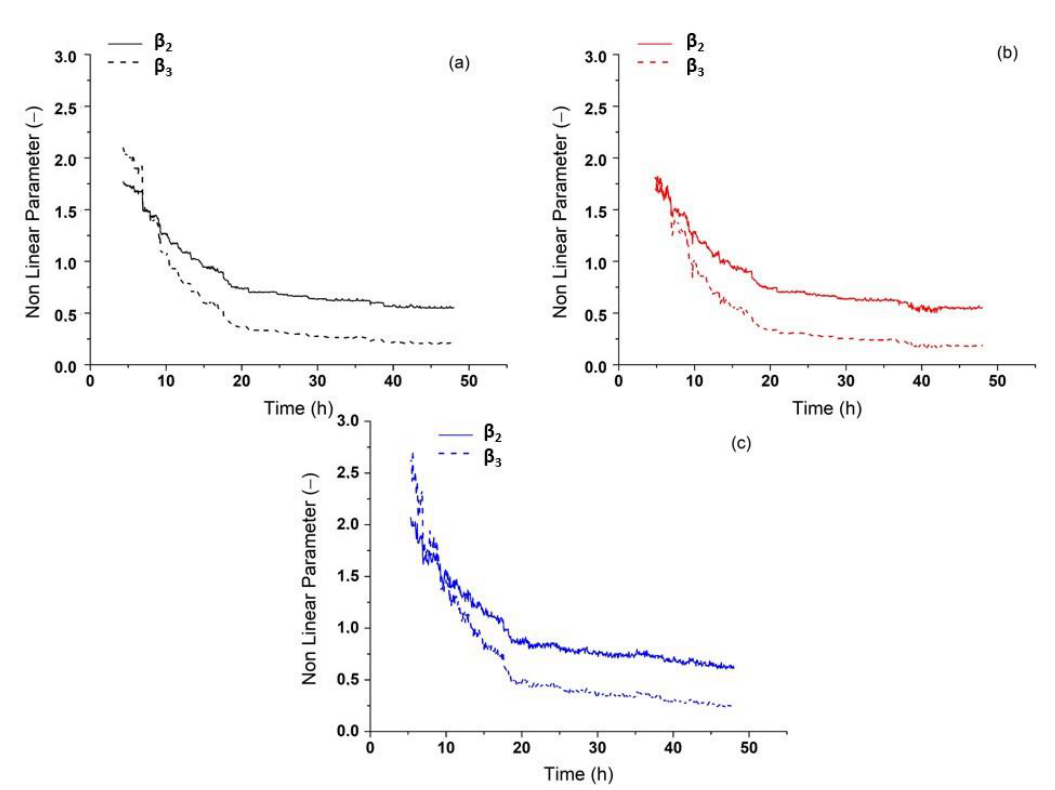
Figure 9. Typical results of cement paste’s nonlinearity parameters for ( a ) w/c = 0.4, ( b ) w/c = 0.5 and ( c ) w/c = 0.6.